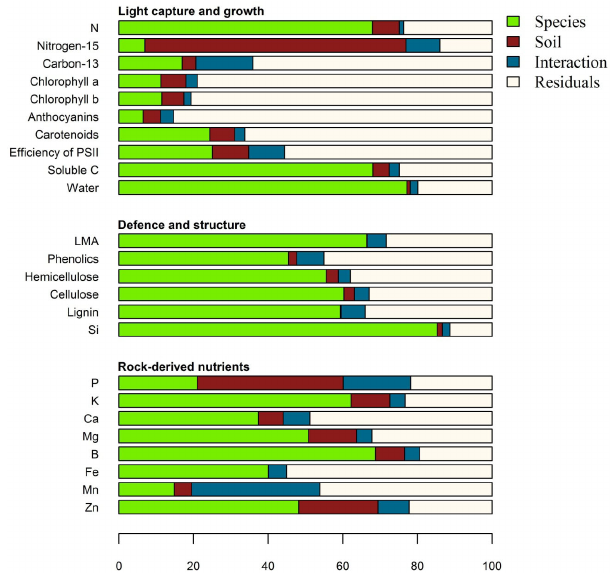
Figure 1. Partitioning of variance of foliar traits between species, soil, species–soil interaction and residual components for six gen- eralist species found on both chalk and alluvial soils. Residual vari- ation arises from within-site intraspecific variation, microsite vari- ability, canopy selection and measurement error